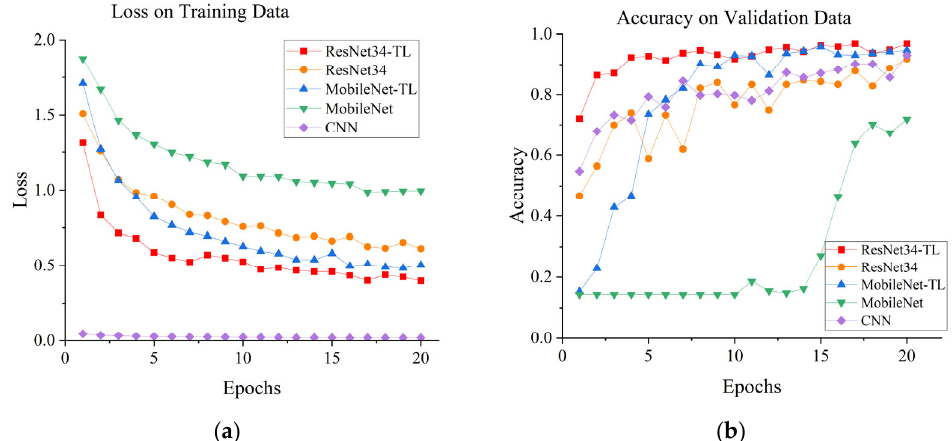
Figure 6. Experimental results for all models: ( a ) training set loss; ( b ) validation set accuracy.